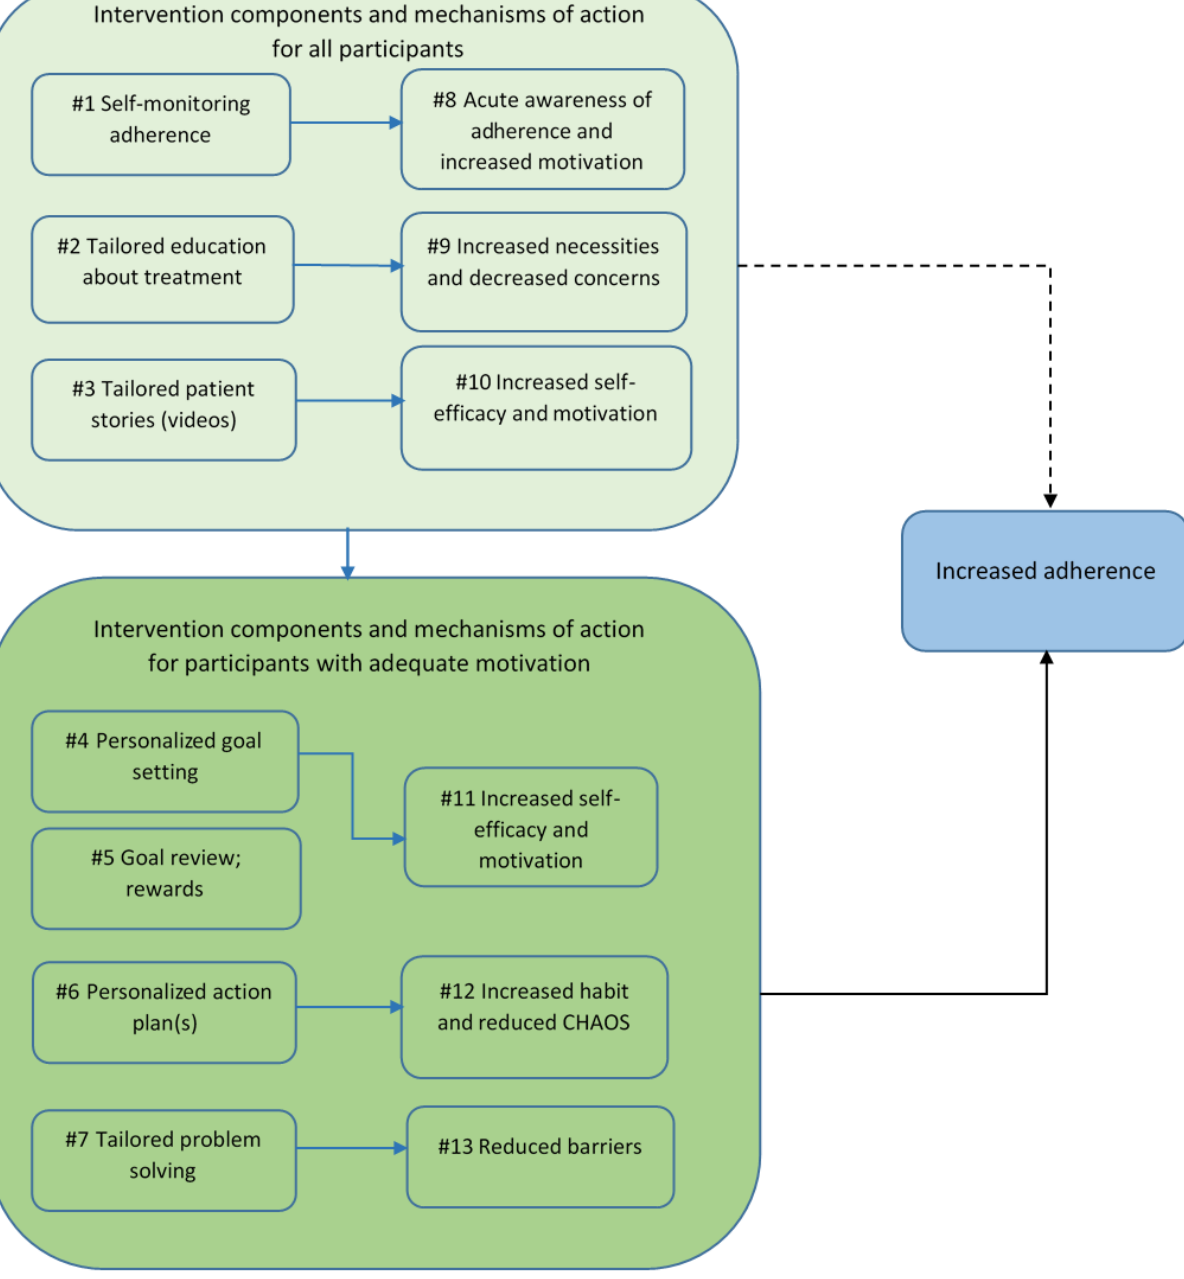
Figure 1. Theoretical model of behavior change to increase adherence in adults with cystic fibrosis. The Confusion, Hubbub, and Order Scale is a 6-item measure of life chaos. CHAOS: Confusion, Hubbub, and Order